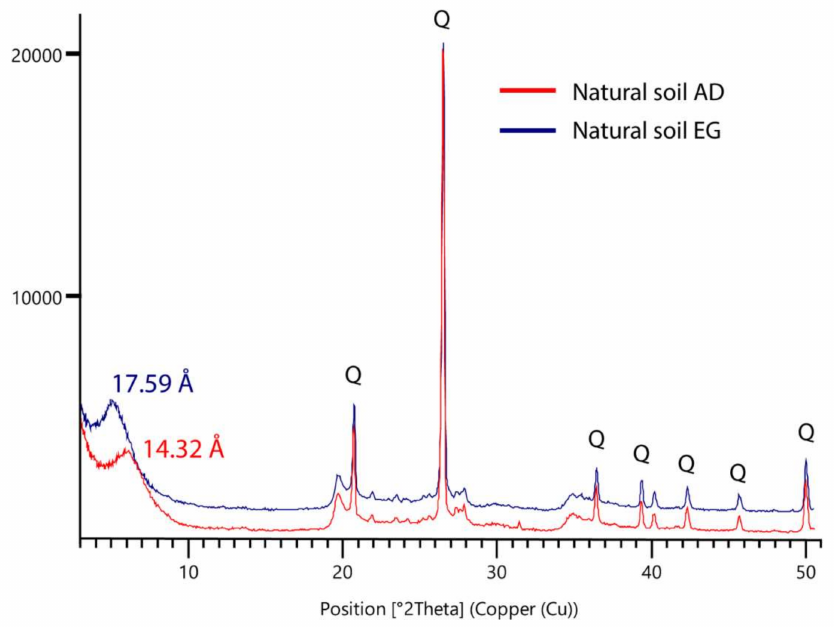
Figure 3. Ethylene glycol (EG)-treated and air-dried (AD) experimental spectra. Numbers indicate the montmorillonite d 001 spacing in Å.